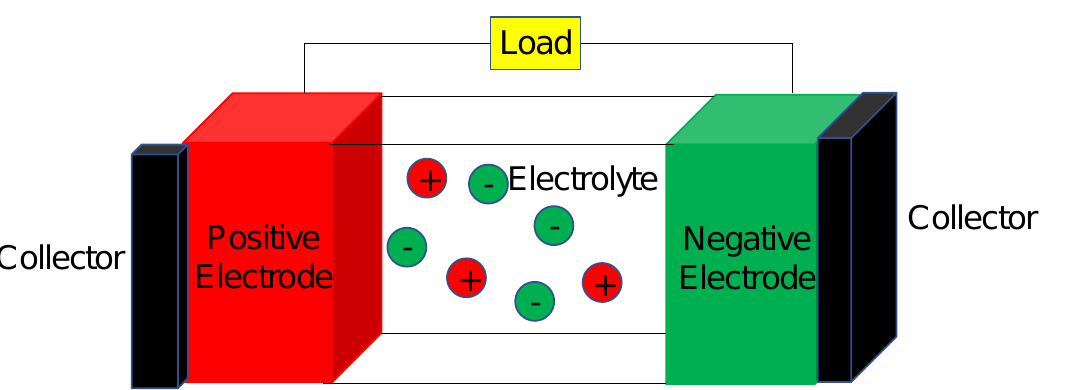
Figure 8. The principle of an electrochemical energy storage system.